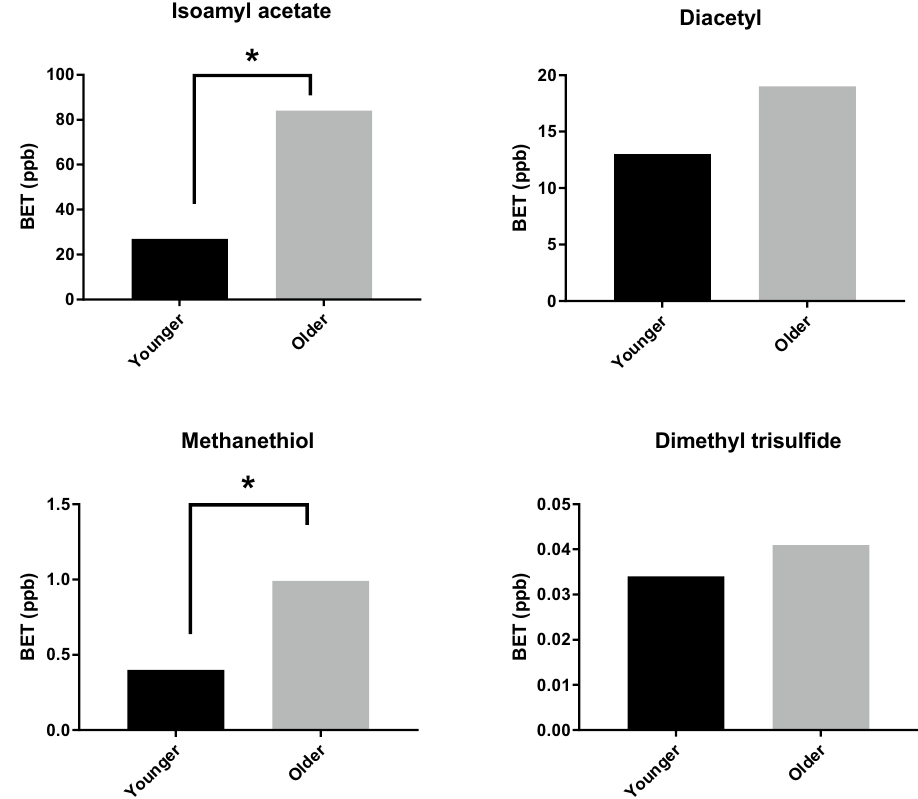
Figure 5. Best estimate detection threshold values (BET), for both younger and older adults, for the four aroma compounds studied. Statistically significant differences, as analysed by The Mann–Whitney U test, are marked by * for p <